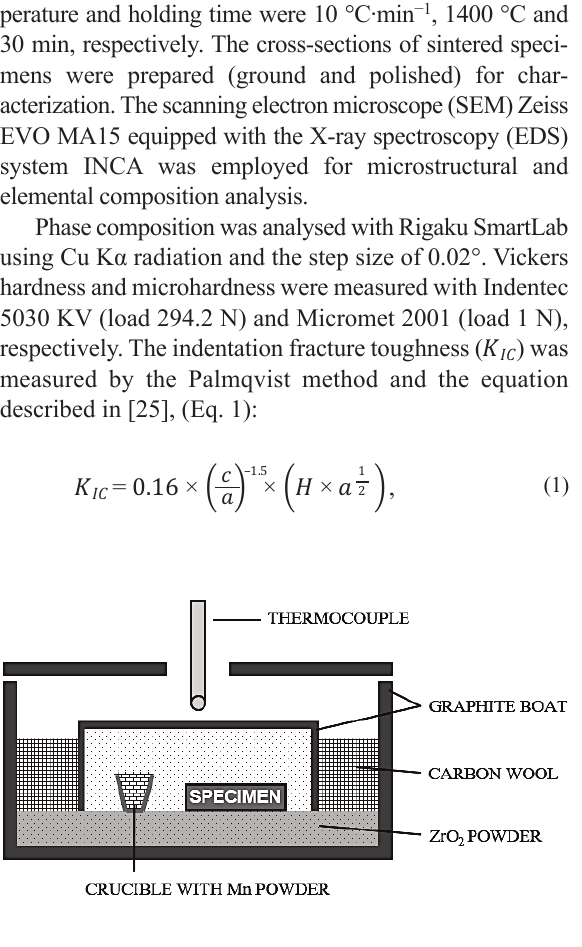
Fig. 1. Schematic build-up of the graphite crucible which includes the manganese vapour “microatmosphere”. Table 1. Description of starting powders